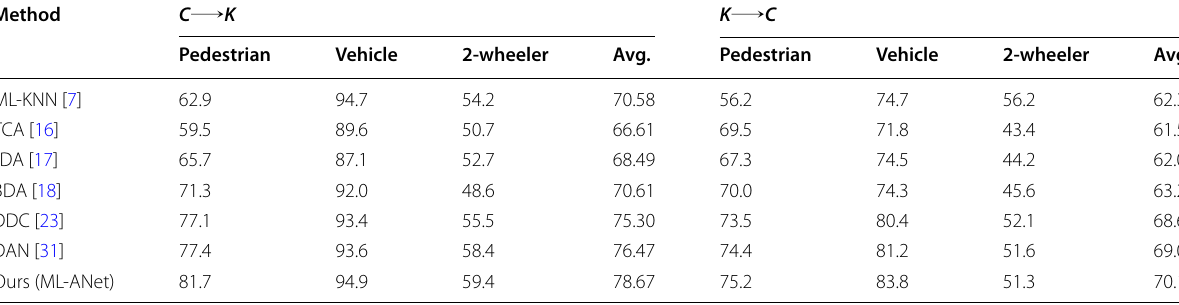
Table 4 Comparison of classification accuracies (%) on Cityscapes and KITTI datasets